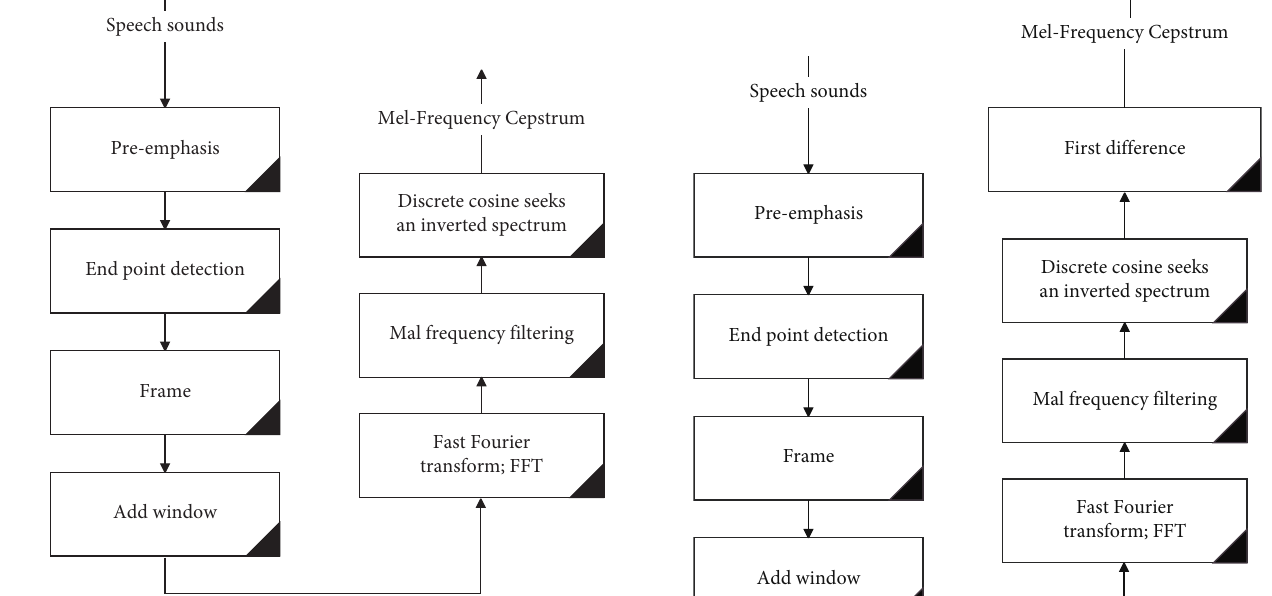
Figure 1: Flow chart of voice conversion into MFCC parameters.